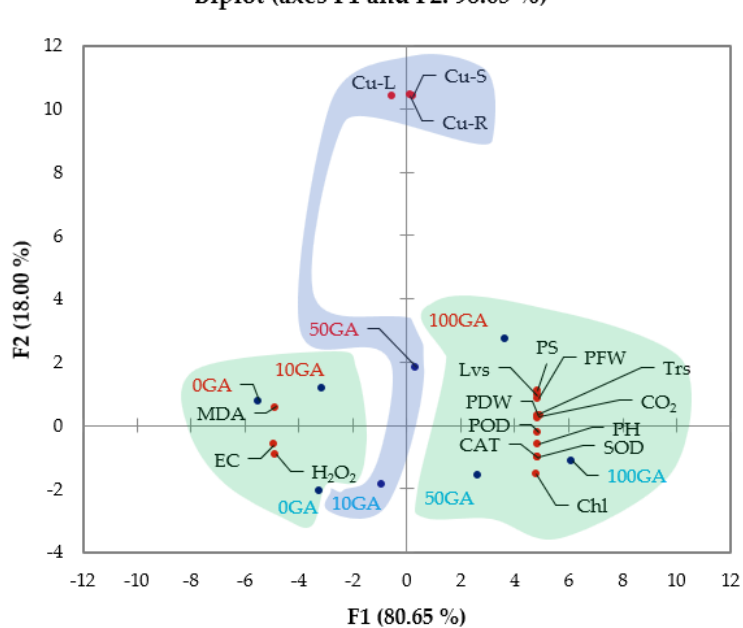
Figure 4. Principal component analysis (biplot) among observations (treatments) and variables (morphological, physiological, and oxidative attributes) of peas. Blue and red colored text depicts GA 3 treatments on plants grown in Cu− and Cu+, respectively. Clustering of observations and variables into groups (colored shading) is based on their highest squared cosine values corresponding to the factor, F1 (green) and F2 (blue). Abbreviations: 0GA—no GA 3 treatment; 10GA—10 mg·L −1 GA 3 ; 50GA—50 mg·L −1 GA 3 ; 100GA—100 mg·L −1 GA 3 ; PH—Plant Height; PFW—Plant Relative Fresh Weight; PDW—Plant Dry Weight; Lvs—Number of Leaves; Chl—Chlorophyll Content; PS—Photosynthetic Rate; Trs—Transpiration Rate; CO 2 —CO 2 Index; MDA—Malondialdehyde